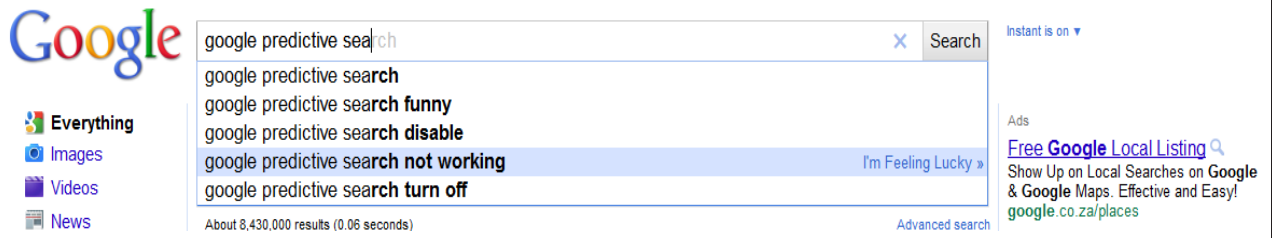
FIGURE 1: Google’s predictive search